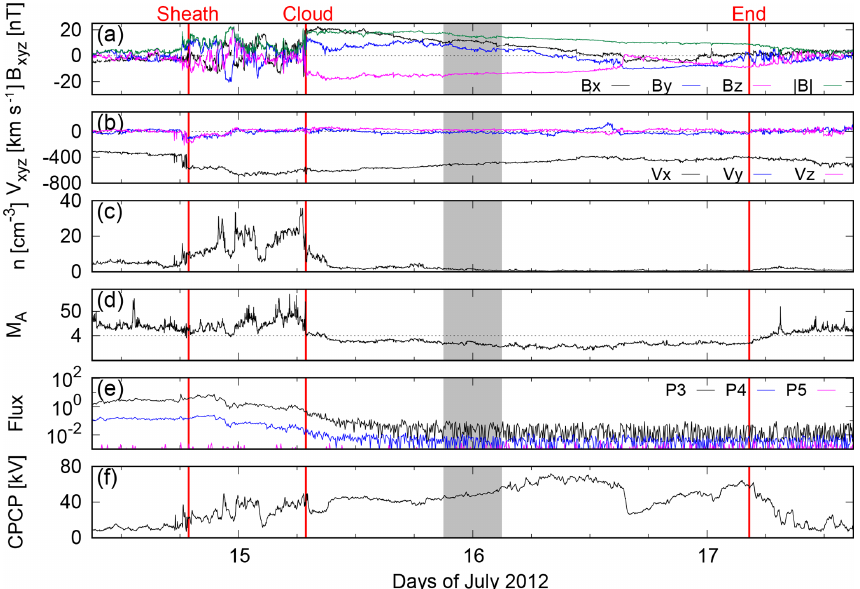
Figure 1. Solar wind and IMF conditions during 14 July 09:00UT–17 July 15:00UT, 2012. Panels from top to bottom: (a) IMF components B X , B Y and B Z and the IMF magnitude in nT, (b) plasma velocity components V X , V Y and V Z in kms − 1 , (c) plasma number density n in cm − 3 , (d) upstream Alfvén–Mach number M A ( M A = 4 is marked with a dotted line), (e) GOES-15 geostationary orbit proton fluxes for three energy channels between 8 and 80MeV, and (f) the ionospheric cross-polar cap potential from GUMICS-4. Data in panels (a) – (d) are measured by ACE/Wind. Vertical red lines indicate the onset of the ICME sheath/magnetic cloud or the end of the ICME event. Grey background shows the part of the ICME event that is simulated using both 0.25 and 0.5 R E as a maximum spatial resolution.